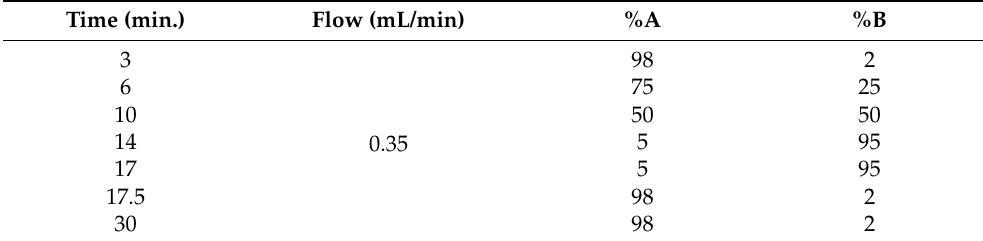
Table 3. Gradient elution of HPLC-DAD.